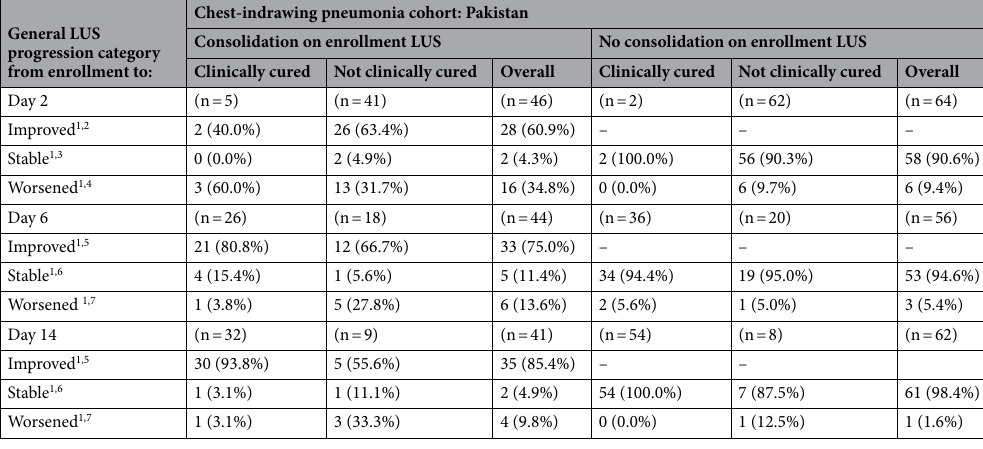
Table 4. Progression of consolidation on lung ultrasound (LUS) by Days 2, 6 and 14 clinical status in Pakistan. 1 Percentage of children with known progression category. 2 Comparison of enrollment and Day 2 LUS showing decreased number or size(s) ≥ 0.5 cm of consolidation(s), without any increase(s). 3 Comparison of enrollment and Day 2 LUS showing no observed changes to number or size(s) ≥ 0.5 cm of consolidation(s). 4 Comparison of enrollment and Day 2 LUS showing increased number or size(s) ≥ 0.5 cm of consolidation(s). 5 Comparison of enrollment and Day 6 or Day 14 (as applicable) LUS showing decreased number or size(s) ≥ 1 cm of consolidation(s), without any increase(s). 6 Comparison of enrollment and Day 6 or Day 14 (as applicable) LUS showing no observed changes to number or size(s) ≥ 1 cm of consolidation(s). 7 Comparison of enrollment and Day 6 or Day 14 (as applicable) LUS showing increased number or size(s) ≥ 1 cm of